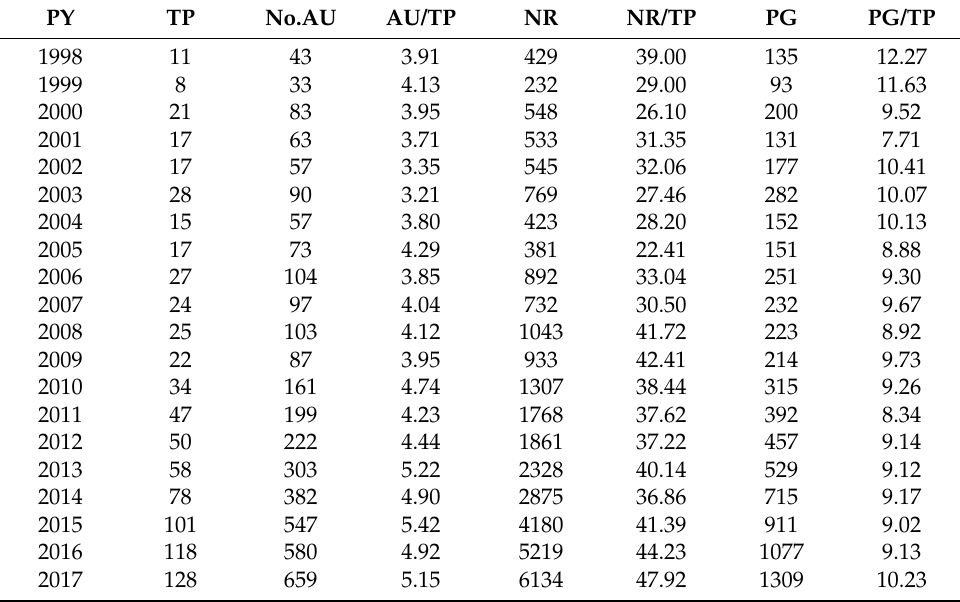
Table 3. Characteristics of periodical articles from 1998 to